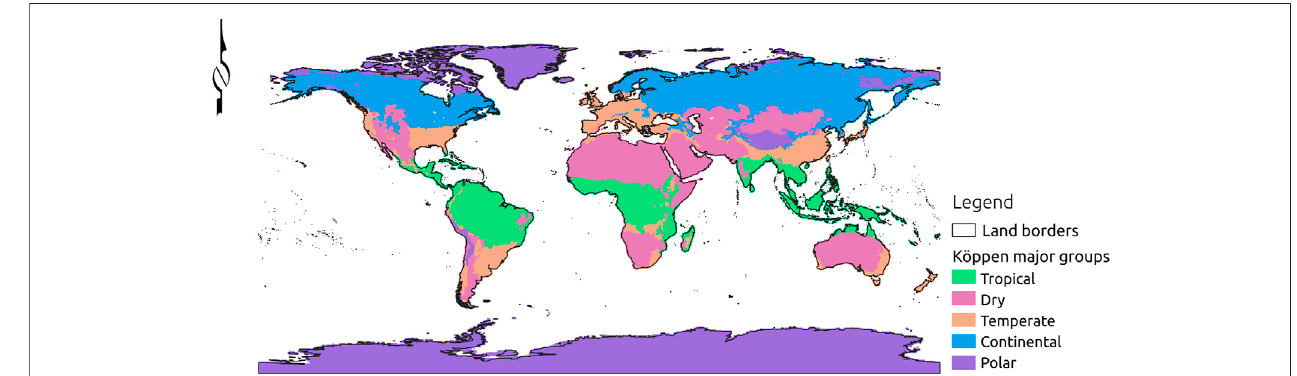
FIGURE 3 | Major Köppen climate groups used for drought propagation study.